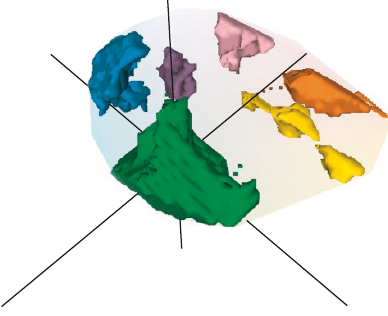
Figure 6: Surfaces delimiting the 11 color categories corresponding to a membership value p =